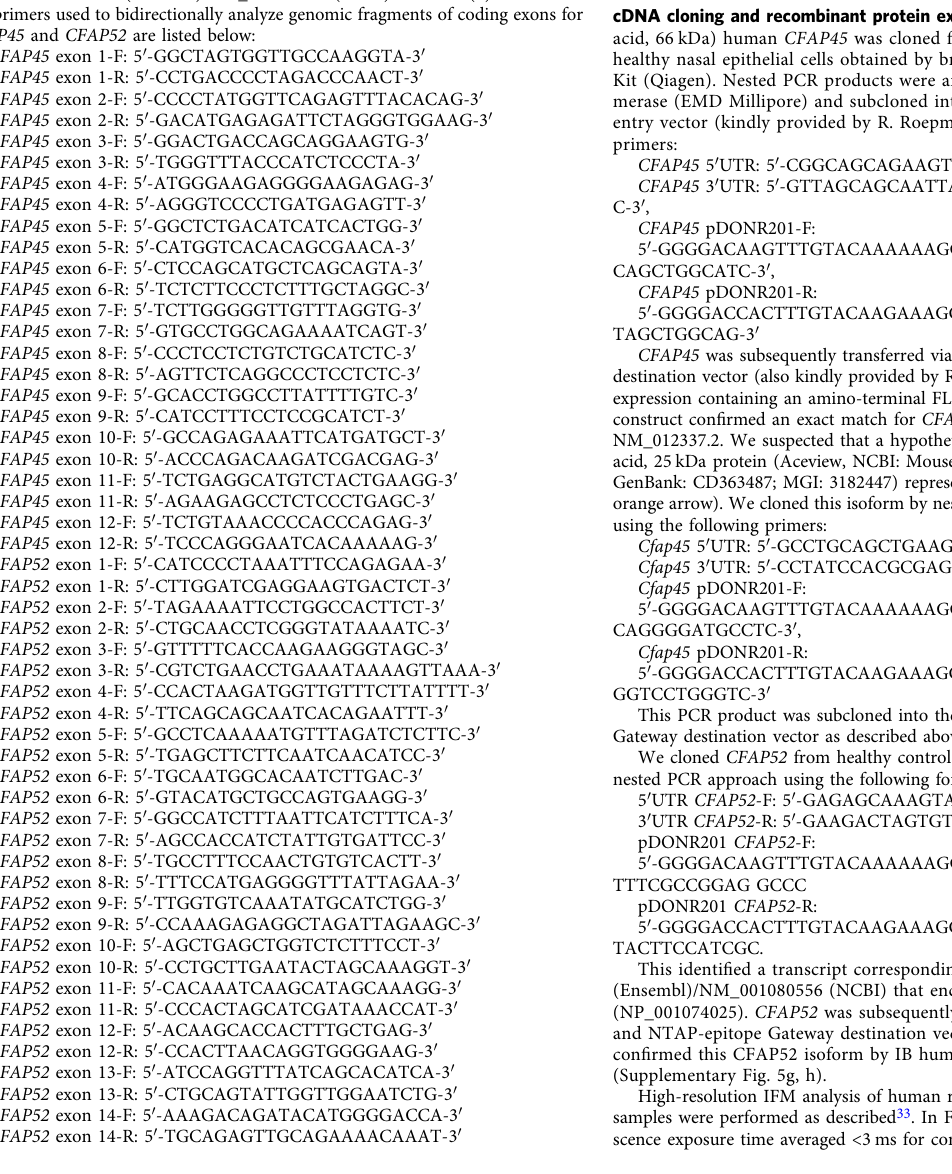
Fig. 7 CFAP45 mediates adenine nucleotide homeostasis via AMP binding. a AMP-binding screen using AMP conjugated to agarose (blue circles) in four orientations (see also “ Methods ” ). b CFAP45 immunoprecipitates from human sperm show af fi nity to AMP including 6AH-AMP-agarose following elution and IB with anti-CFAP45 antibody. c Coomasie-stained gel shows recombinant CFAP45- and AK8-enriched lysates recovered by TAP. d NTAP-CFAP45 shows af fi nity to AMP including 6AH-AMP-agarose by silver stain. e NTAP-AK8 shows af fi nity to α AH-AMP-agarose following elution and IB with monoclonal anti-FLAG antibody. f MT-sliding assay to reconstitute dynein ATPase activity. g 1 mM ATP or 1 mM ADP alone does not signi fi cantly reactivate sliding percentage of Cfap45 − / − sperm compared to control (*** p < 0.0001); however, 1 mM ADP signi fi cantly increases sliding percentage of Cfap45 − / − sperm compared to 1 mM ATP (comparison of + / − , p = 0.3702, not signi fi cant; − / − , ** p = 0.0042; data are means ± SEM; signi fi cance assessed by Fisher ’ s exact test); 1 mM AMP alone shows negligible (<1%) reactivation, similar to untreated control. h Combination of either 4 mM AMP ( n = 113 sperm from 2 experiments, * p = 0.0432) or 4 mM ADP ( n = 93 sperm over 2 experiments, p = 0.3781) with 1 mM ATP increases sliding percentage of Cfap45 − / − sperm, compared to heterozygous control (data are the means± SEM; signi fi cance supported by Fisher ’ s exact test); equimolar ratios of 1 mM AMP or 1 mM ADP with 1 mM ATP does not signi fi cantly reactivate Cfap45 − / − sperm sliding percentage compared to control (data are means ± SEM; signi fi cance assessed by Fisher ’ s exact test; *** p < 0.0001). i Close-up view of AMP bound at the interface of CFAP45 · AK8 complex. Carbon atoms in AMP, CFAP45, and AK8 are colored in green, yellow, and gray, respectively; nitrogen, oxygen, and phosphorus atoms are colored in blue, red, and orange, respectively. Distances shown by thin-dash lines are in Angstroms (Å). j Sequence alignments highlighting highly conserved CFAP45 residues Arg479 and Arg483- and AMP-binding site of AK8 (residues 354-357, black bar). Conserved residues highlighted in gray; arginine residues highlighted in orange. See also Supplementary Fig. 11 and “ Methods ”